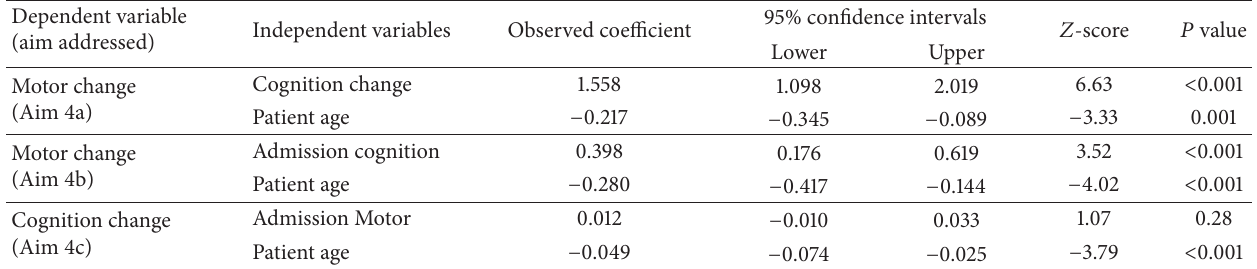
Table 3: Summary of coefficients (and bootstrap generated confidence intervals), 𝑍 -scores, and 𝑃 values from the generalised linear models utilizing Functional Independence Measure change